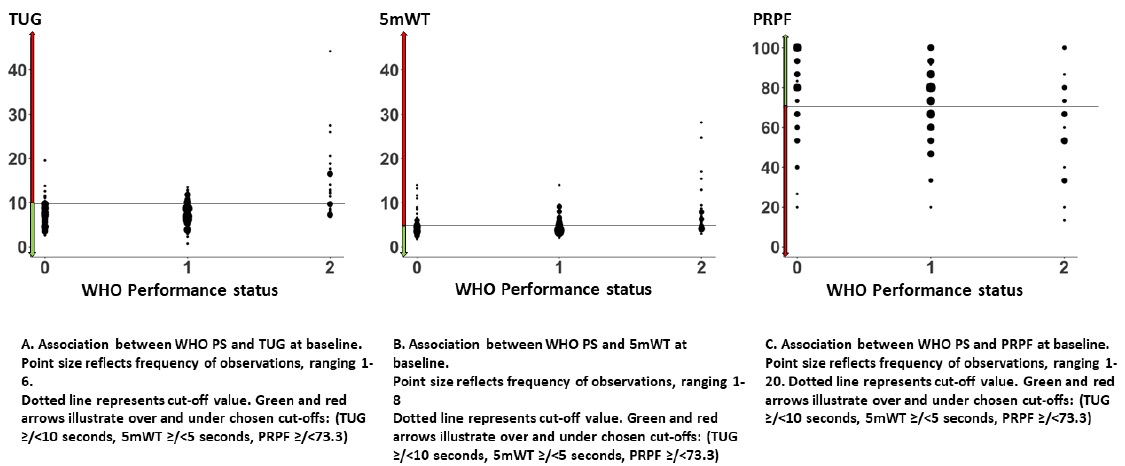
Figure 2. Associations between WHO performance status and timed up and go, 5-meter walk test, and patient-reported physical function.